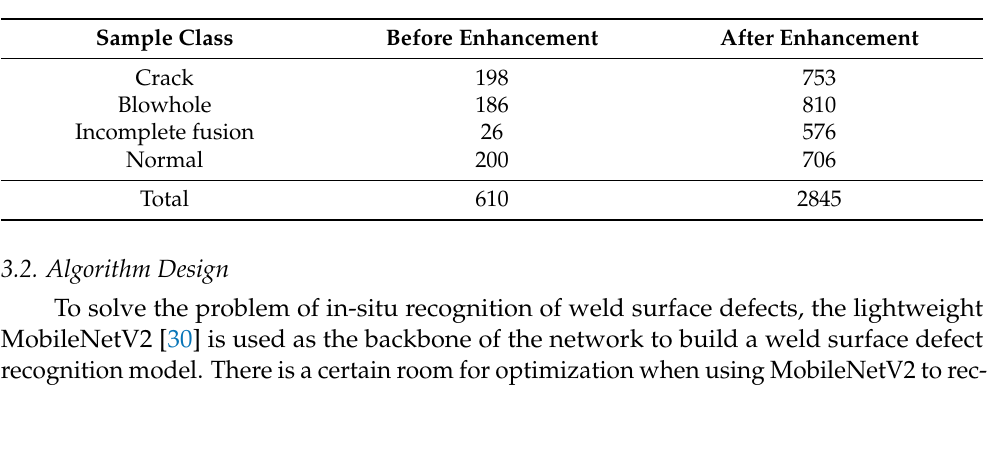
Figure 3. Comparison of defect images before and after enhancement.